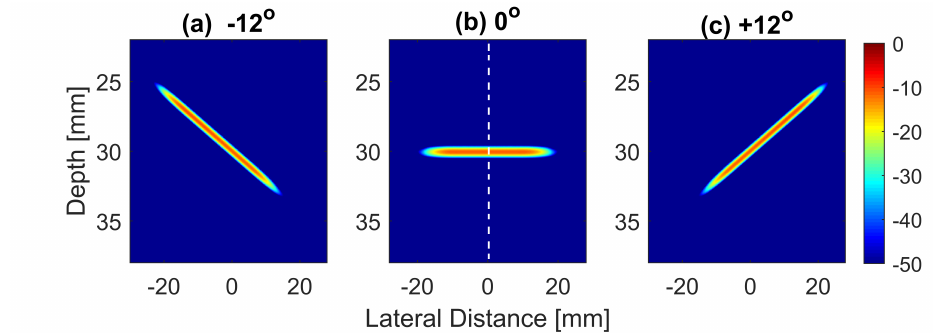
Figure 1. Normalized and log-compressed pressure fields for plane waves steered at ( a ) − 12 ◦ , ( b ) 0 ◦ and ( c ) + 12 ◦ . A transmit apodization with a Tukey window ( α = 0.5 ) was applied to all emitted pressure fields in order to eliminate the edge waves on both sides of the